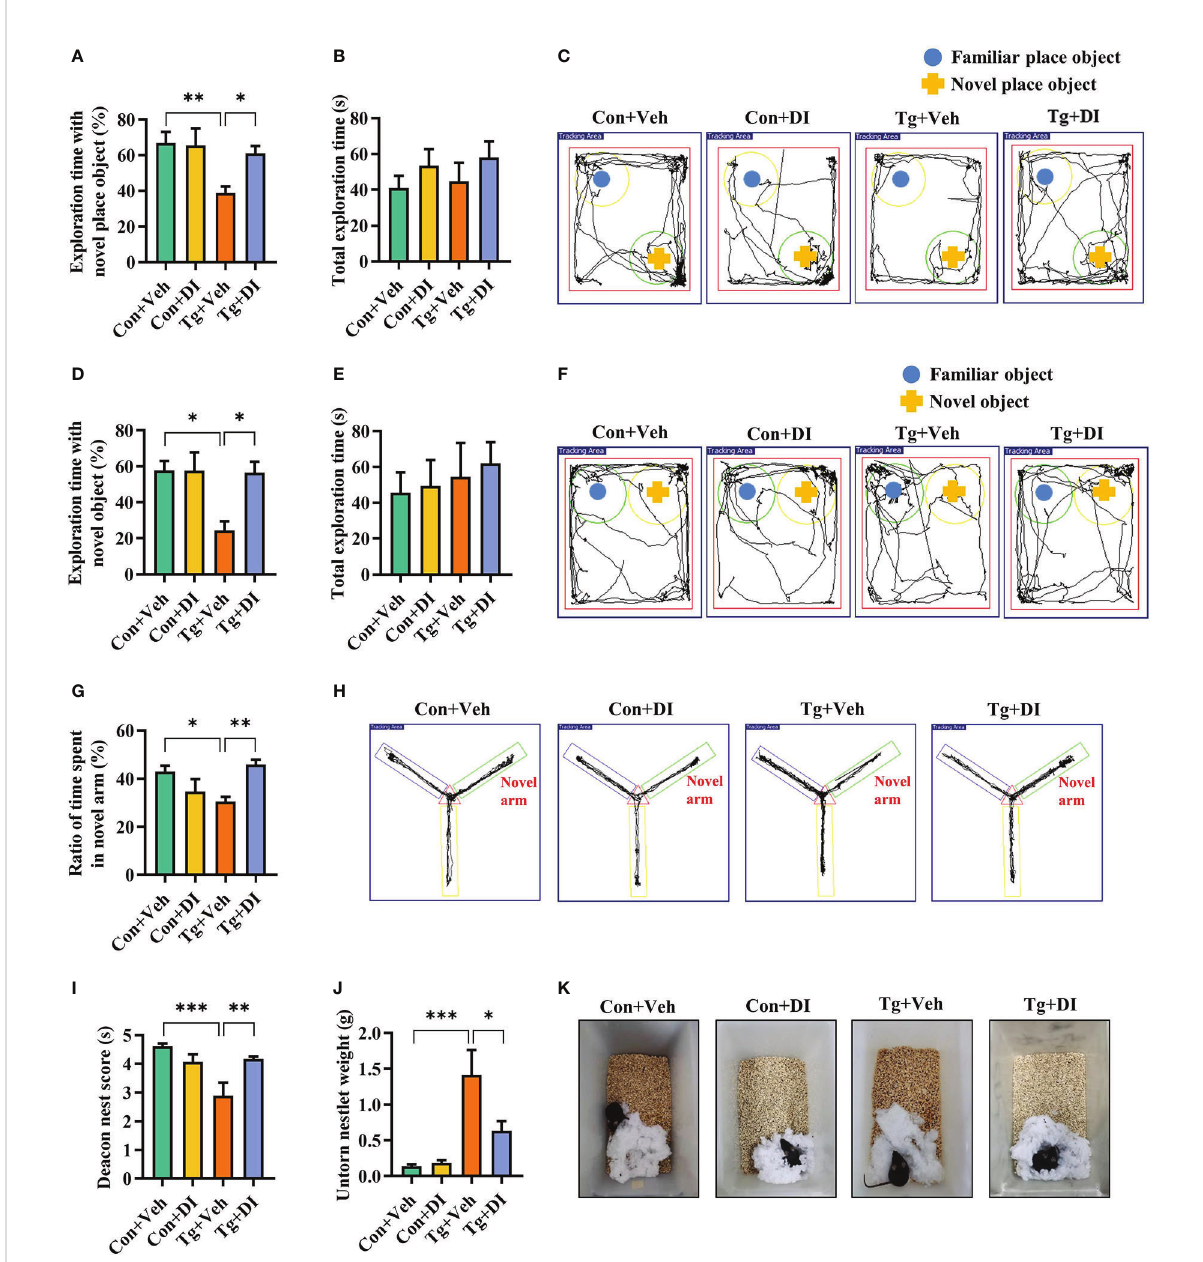
FIGURE 5 Dimethyl itaconate improves the cognitive de fi cits in T. gondii infected mice. (A) Percentage of time spent with the object in the novel place to total object exploration time and (B) the total object exploration time in the novel location test were recorded. (C) Representative track plots of Con+Veh, Con+DI, Tg+Veh and Tg+DI groups recorded by SMART video tracking system in the testing phase. (D) Percentage of time spent with the novel object to total object exploration time and (E) the total object exploration time in the novel object recognition test were recorded. (F) Representative track plots of Con+Veh, Con+DI, Tg+Veh and Tg+DI groups recorded by SMART video tracking system in the testing phase. (G) Percentage of time spent with the novel arm to total arm exploration time in Y-maze spatial memory test. (H) Representative example of spatial memory in the Y-maze test recorded by SMART video tracking system. Note that the mice in Tg+DI group spent more time exploring the novel arm than the mice infected with T. gondii. (I) The nest score and (J) untorn nestlet weight (amount of untorn nesting material) ( n = 10 mice for each group). (K) Representative nesting result of Con+Veh, Con+DI, Tg+Veh and Tg+DI groups. Con+Veh, control mice with vehicle control treatment; Con+DI, control mice with DI treatment; Tg+Veh, T. gondii infected mice with vehicle control treatment; Tg+DI: T. gondii infected mice with DI treatment. Values are mean ± SEM. * P <0.05, ** P <0.01, *** P